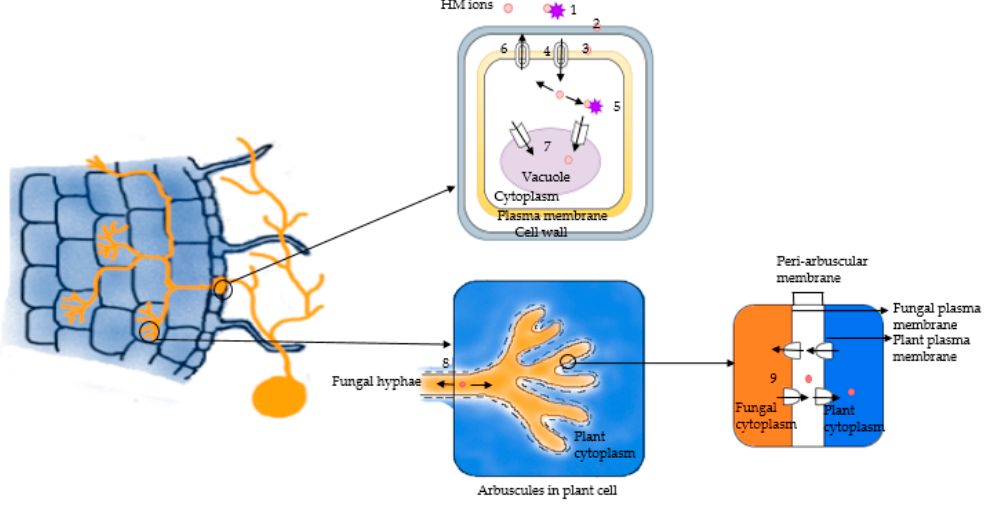
Figure 4. Mechanism of heavy metal (HM) detoxification in plants by arbuscular mycorrhizal symbiosis. (1) Chelating agents (phytochelatins and organic acids from the plant and glomalins from the fungus) bind with HM ions in the soil. (2–4) Transport of metal ions across the cell wall and plasma membrane (acting as selective barrier and with the help of transporters) of plants and fungi. (5) Chelation of HM ions in the cytosol. (6) Export of HMs via active or passive transport from plant or fungal cells. (7) Sequestration of HM ions in the vacuoles of plant and fungal cells. (8) Transport of HM ions in the fungal hyphae. (9) Export of HM ions from the fungus to plant cells via transporters in arbuscules. Modified from [123] with permission.